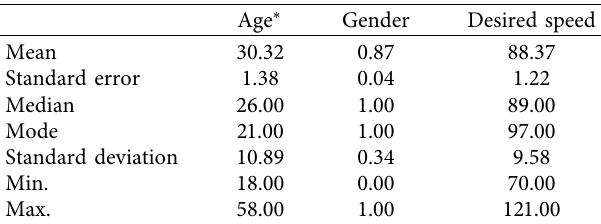
Figure 2: Age distribution of female drivers participating in driving simulator. Table 1: The characteristics of